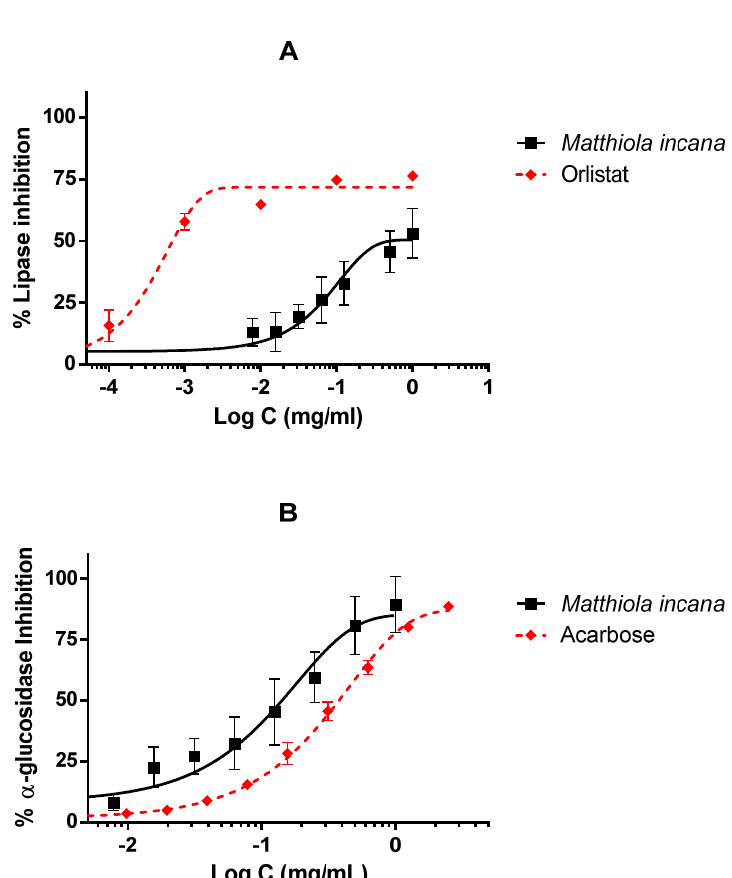
Figure 5. Activity of the hydroalcoholic extract of M. incana aerial parts on lipase ( A ) and α -glucosidase ( B ). IC 50 values were calculated by non-linear regression. All concentrations were tested at least in triplicate, and each point represents mean ± SEM. A: Lipase inhibition performed by M. incana extract and orlistat as standard. B: α -glucosidase ( α -GLU) inhibition by M. incana extract and acarbose as standard.